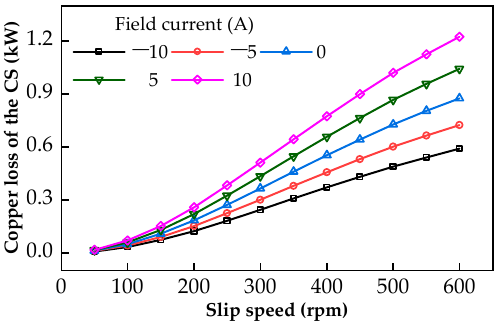
Figure 12. The copper losses of the copper sheet (CS) under different field currents.